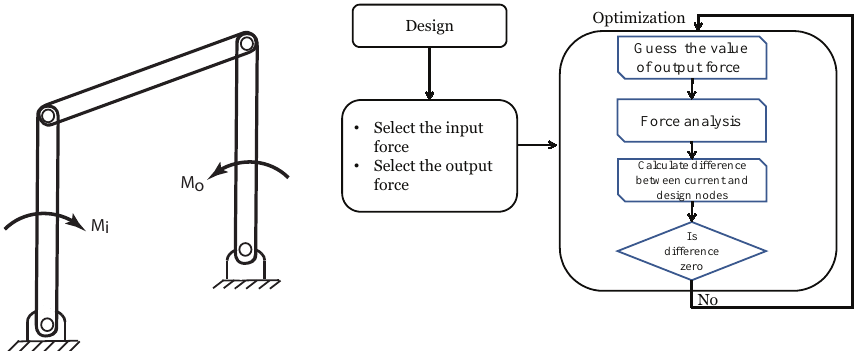
Figure 7. The schematic view (left) and flowchart (right) of mechanical advantage analysis problem. M i is the input moment and M o is the output force. The module will return the ratio of M o /M i .